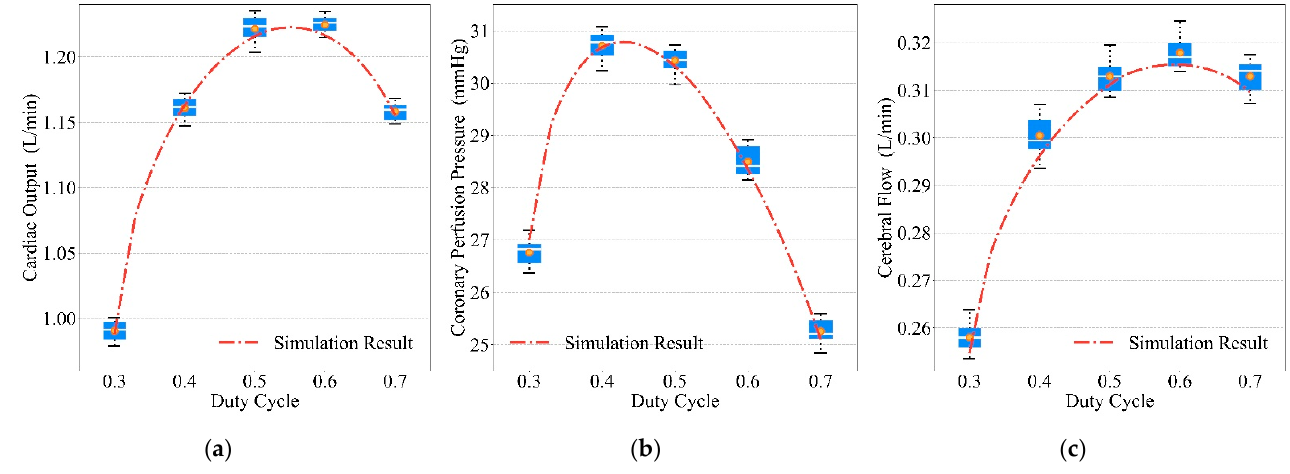
Figure 14. Relationship between duty cycles and blood circulation results: ( a ) CO, ( b ) CPP, ( c ) CF. Table 4. Optimal parameters for